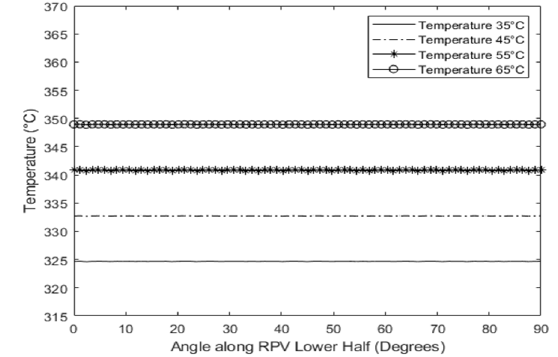
Fig. 11: External temperature variation with the